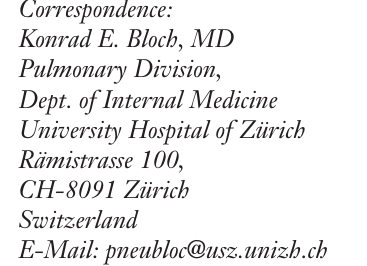
Figure 2 Treatment options for the obstructive sleep apnoea syndrome (OSAS). The standard therapy consisting of nasal continuous positive airway pres- sure (CPAP) and alternative treatment modalities along with suggested evalua- tions are